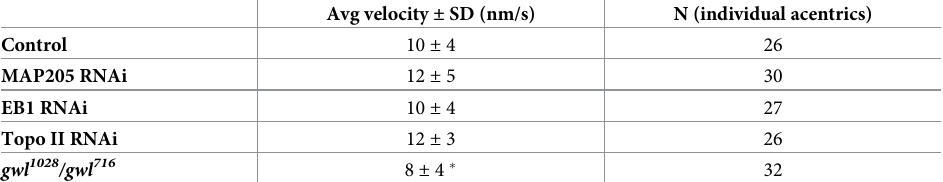
Table 4. Average velocities of acentric segregation. Depicted below are the velocities of individual acentrics as they segregate during anaphase. Velocity is measured in nanometers per second. Segregation velocity is defined as begin- ning when an acentric is clearly observed as separated from its sister and ends when the acentric reaches the daughter nucleus. Asterisks indicate statistical significance ( � P = 0.006) as determined by a two-sided Mann-Whitney test.